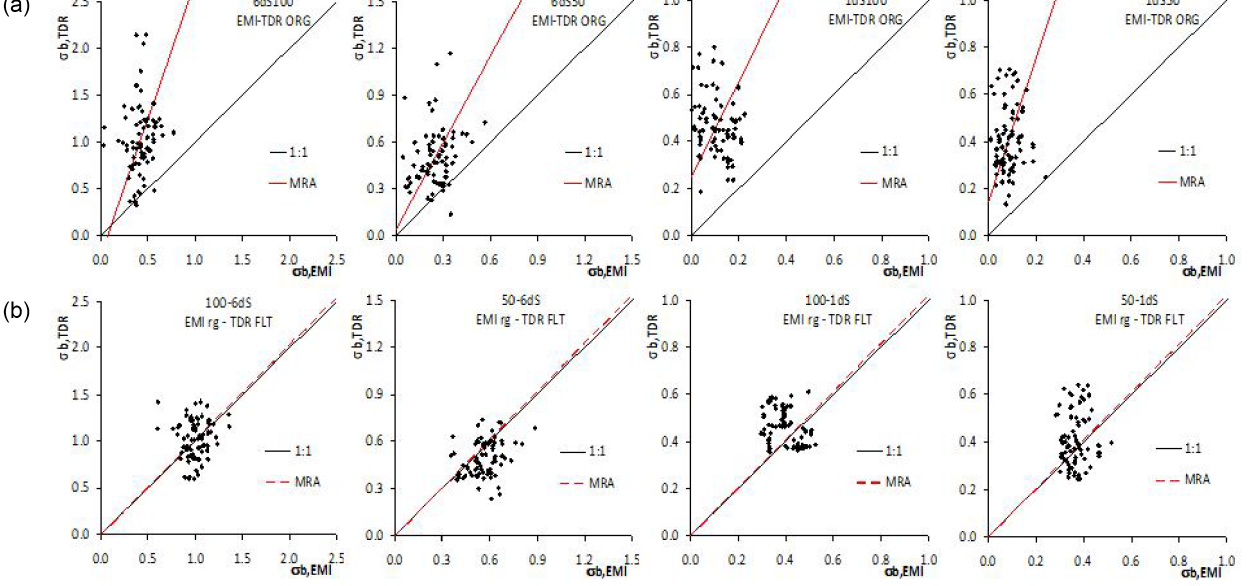
Figure 7. Comparison between σ b , TDR and σ b , EMI for all four transects for the depth range 0.0–0.6m. The graphs in the top panels (a) show the original TDR and EMI data, while those in the bottom panels (b) the filtered (FLT) TDR and EMI data after the regression based on MRA parameters (rg).